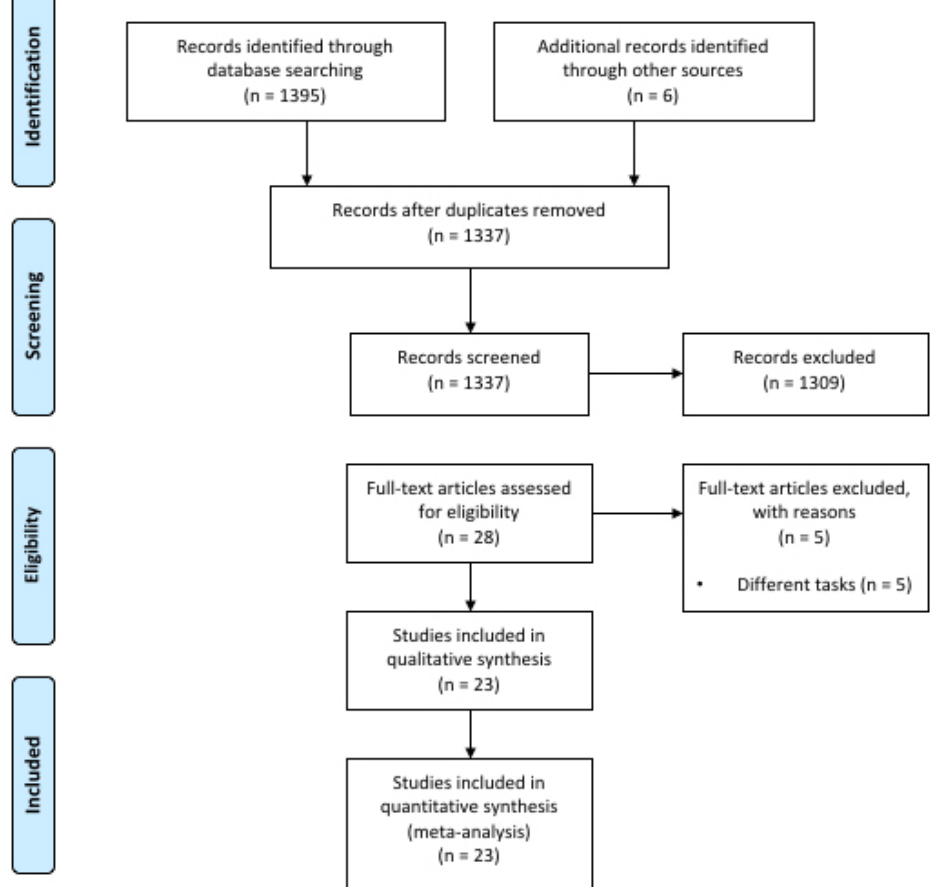
Figure 1. Flow diagram of the literature search.